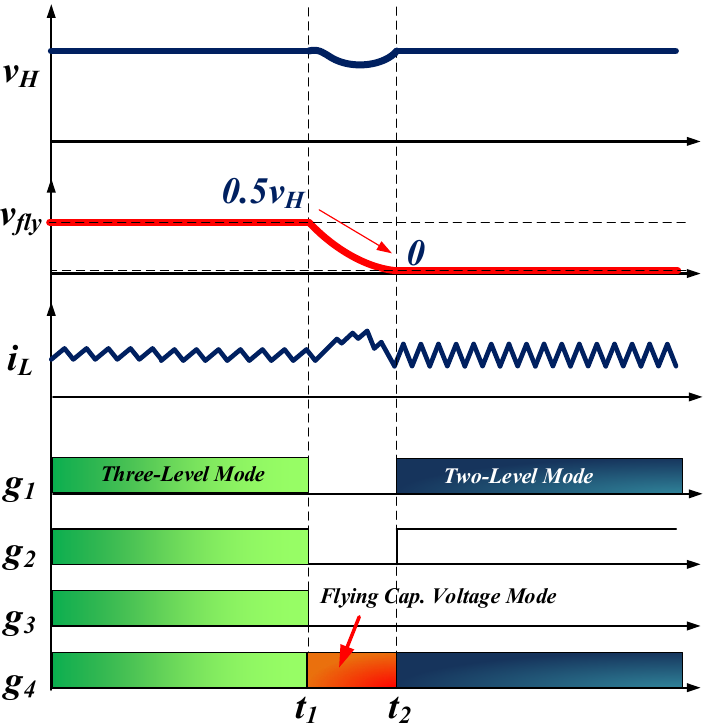
Figure 3. The diagram of the key quantity under the situation in which short-circuit fault occurs in switch S 3 .